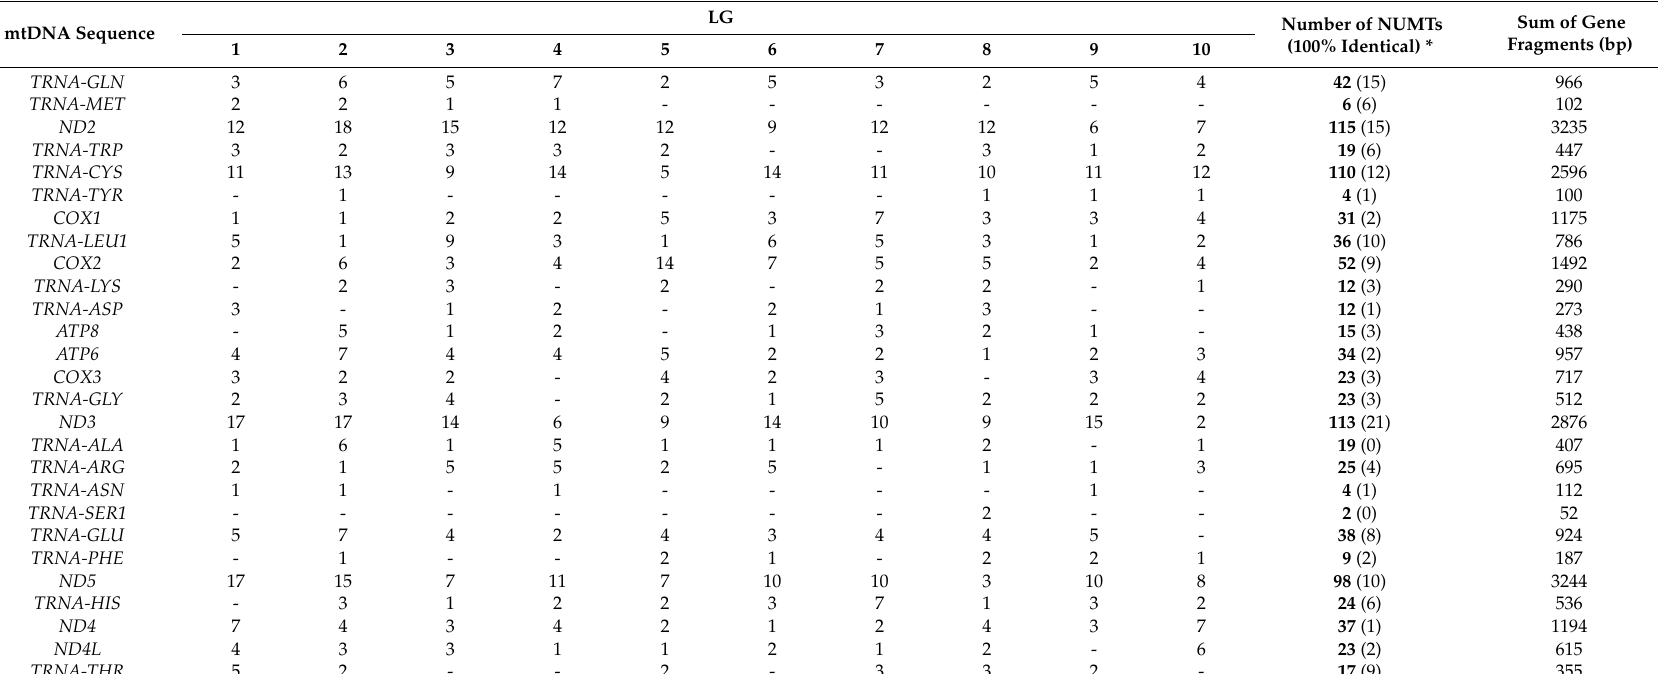
Table 2. Distribution of mtDNA gene fragments in the linkage groups and the sum of fragment